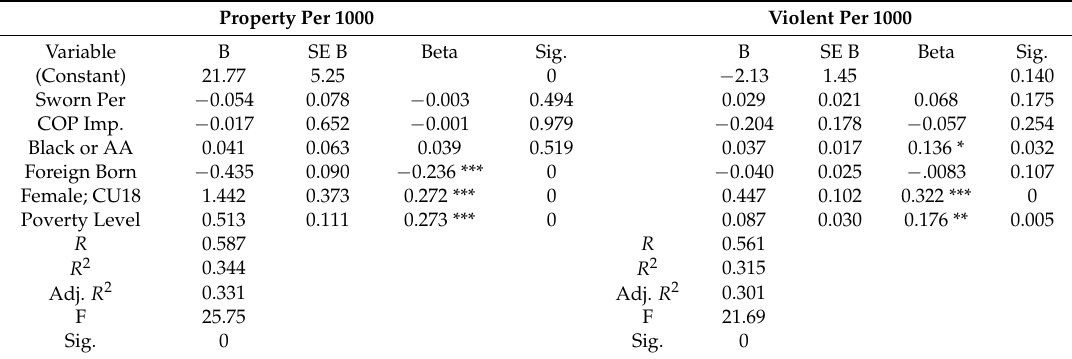
Table 4. Final OLS Regression Model for Property Crime and Violent Crime Rates per 1000 ( n =